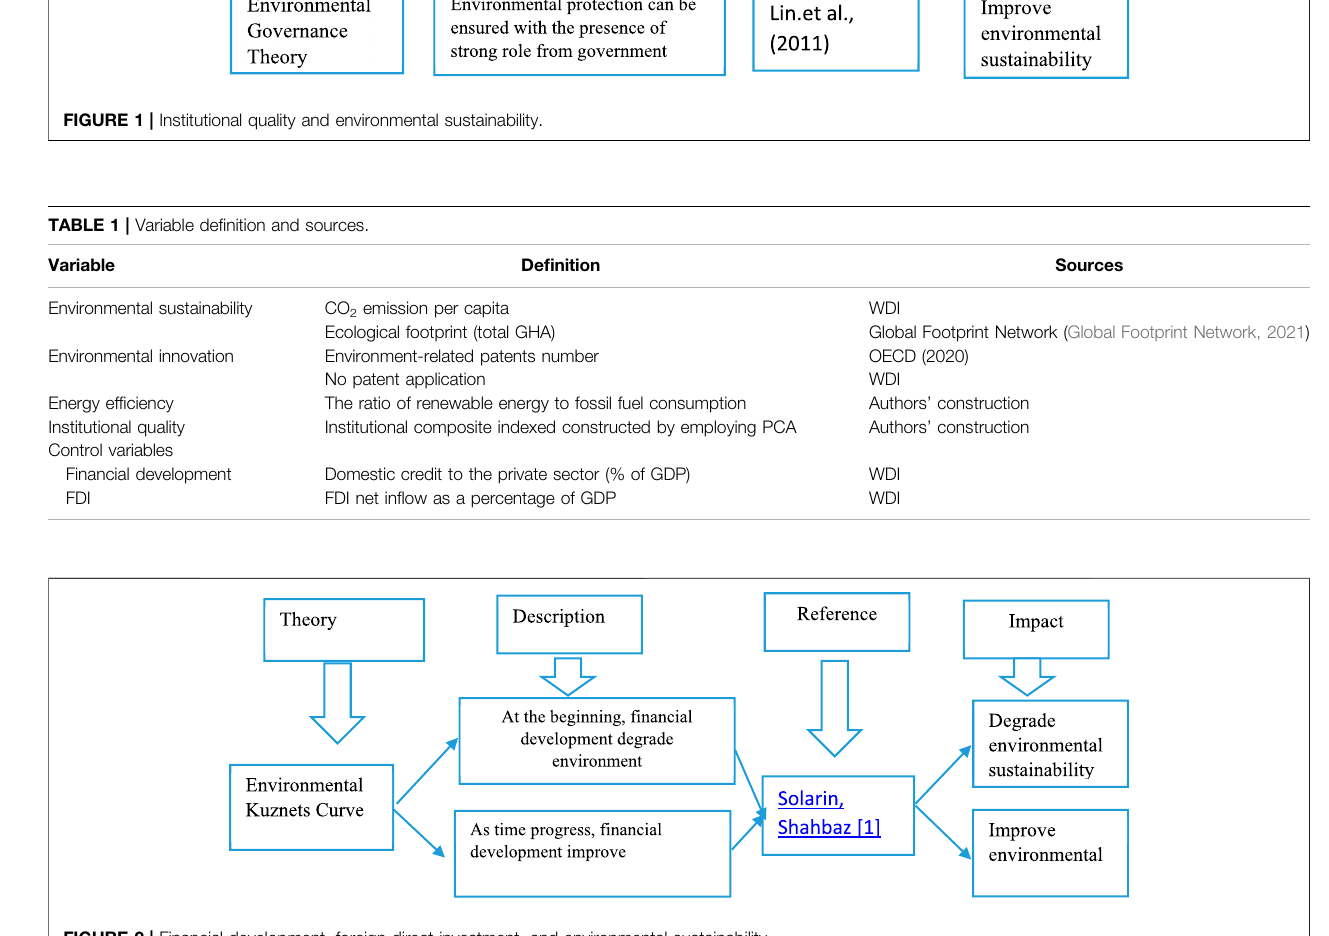
FIGURE 2 | Financial development, foreign direct investment, and environmental